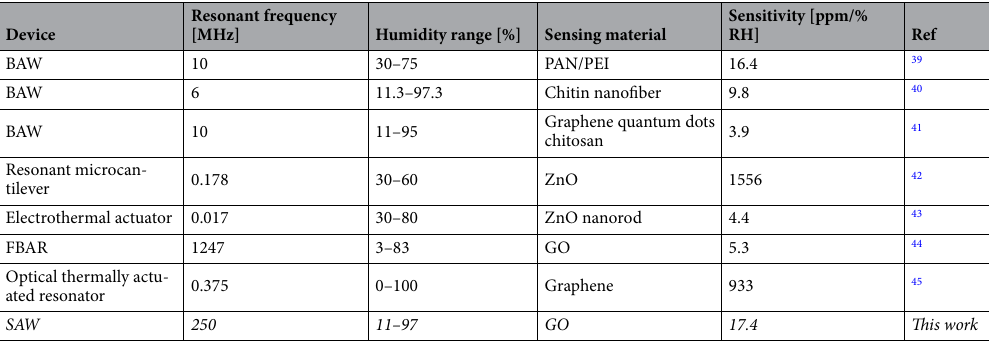
Table 3. Comparison of humidity sensing performance between this work and previously reported work. Significant values are in